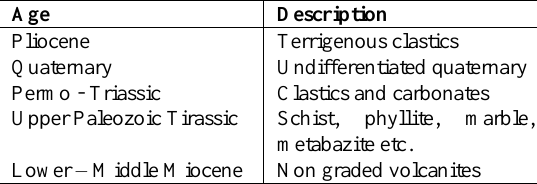
Table 2. Lithological ages and descriptions in the study